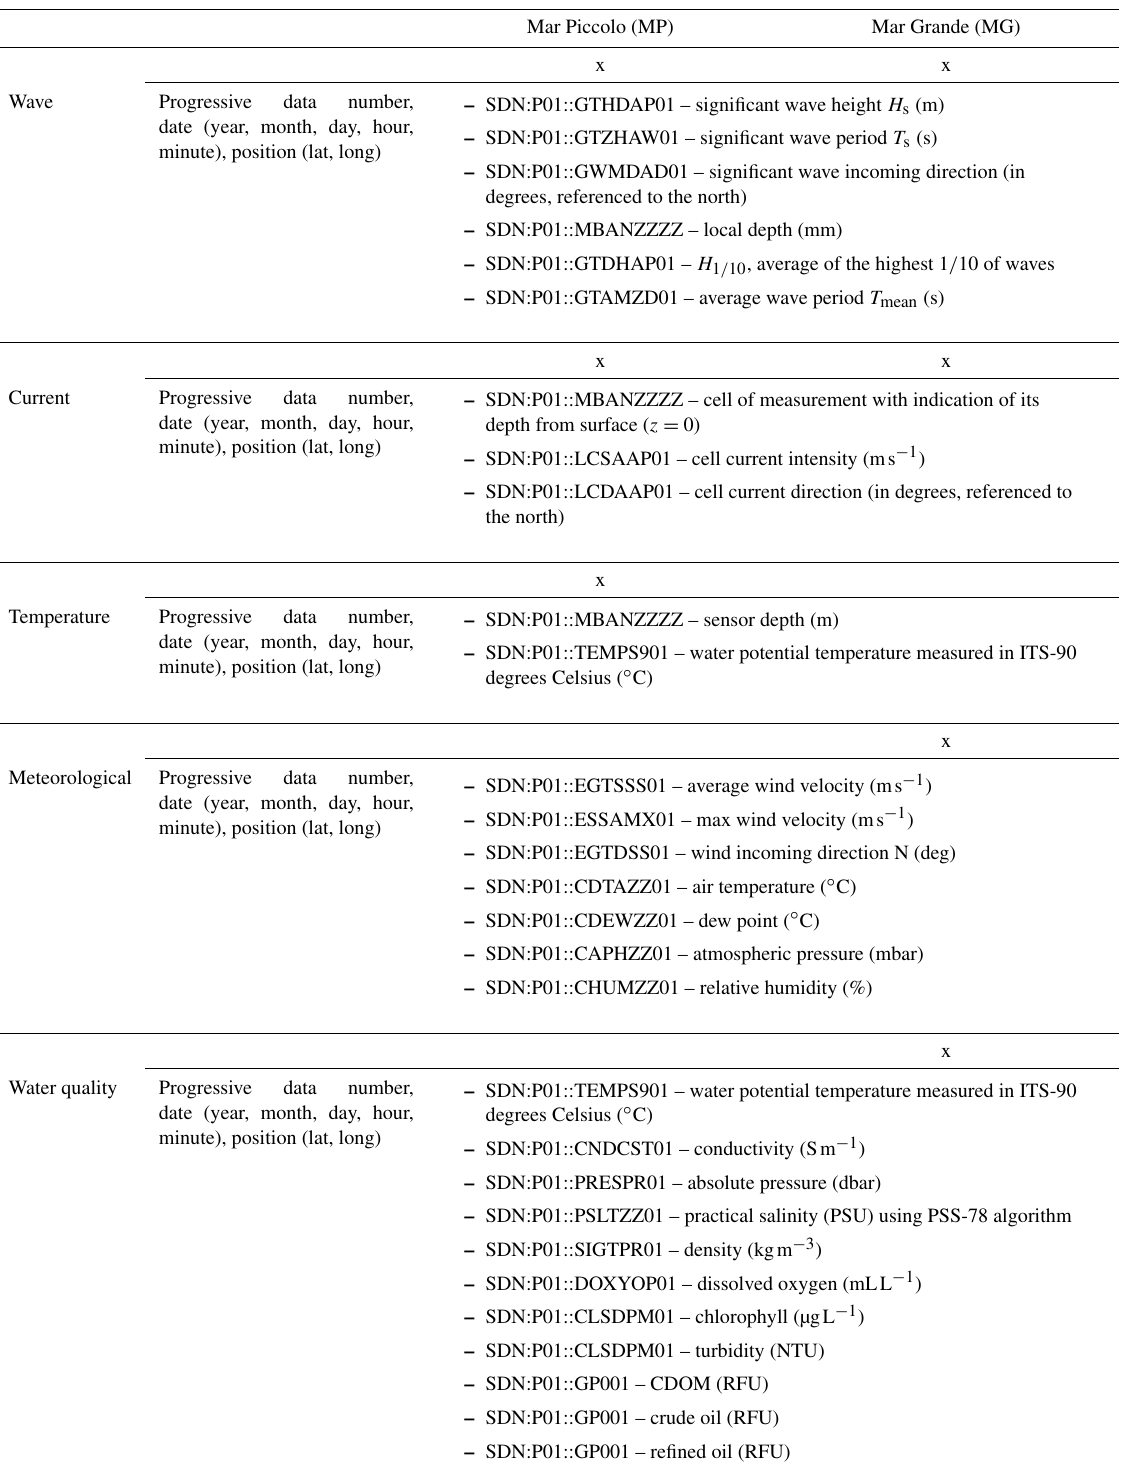
Table 2. Dataset of the two monitoring stations MG and